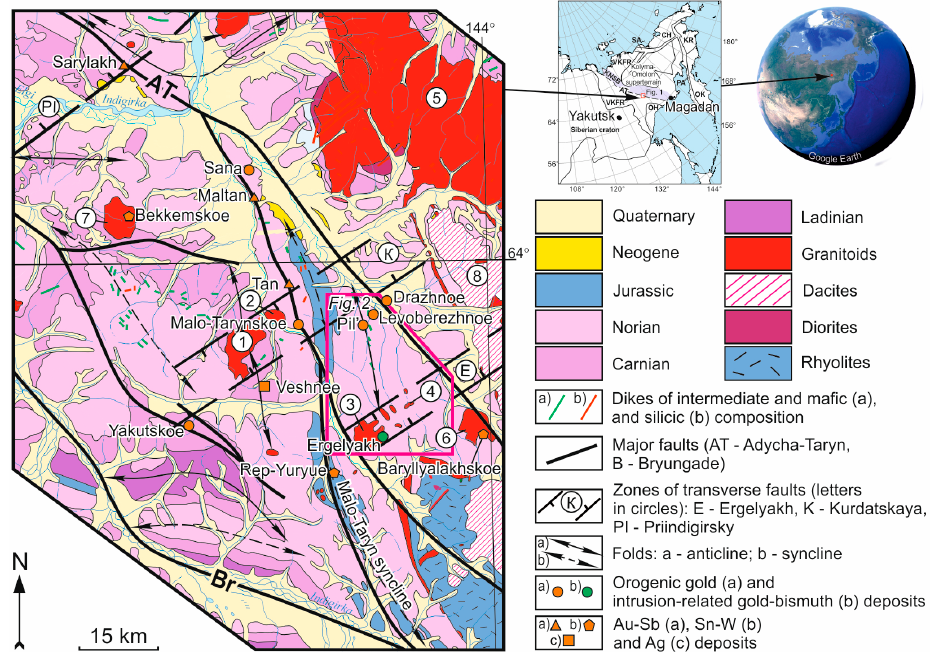
Figure 1. Location of Ergelyakh intrusion-related gold–bismuth deposit in the southeastern Kular-Nera slate belt. Circled figures: 1, Samyr; 2, Kurdat; 3, Ergelyakh; 4, Sokh; 5, Nelkan; 6, Baryllyalakh; 7, Kuranakh-Sala; 8, Taryn subvolcano. Inset shows (modified after [39]): Orogenic belts: SA, South Anyuy; PA, Penzha-Anadyr; Ch, Chukotka; KR, Koryak; OK, Olyutora-Kamchatka; VKFR, Verkhoyansk-Kolyma folded region; KNSB, Kular-Nera slate belt; OH, Okhotsk terrain. The red frame shows the position of Figure 2.